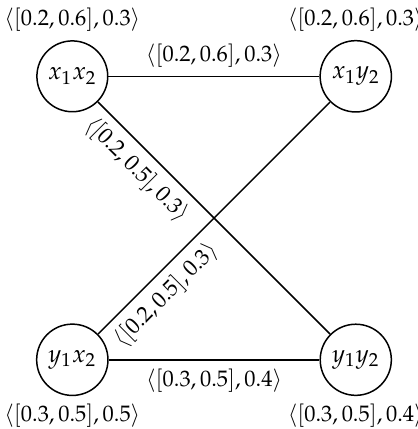
Figure 6. The semi-strong product G 1 and G 2